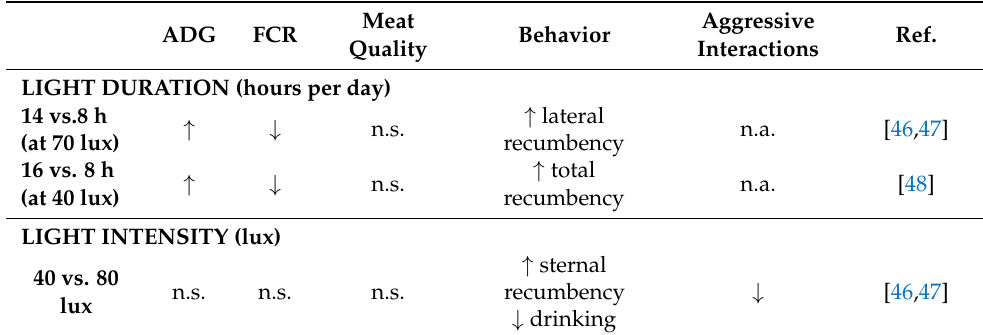
Table 1. Summary of the main findings from studies on illumination requirements of heavy pigs. Aggressive Meat Behavior ADG FCR Interactions Quality